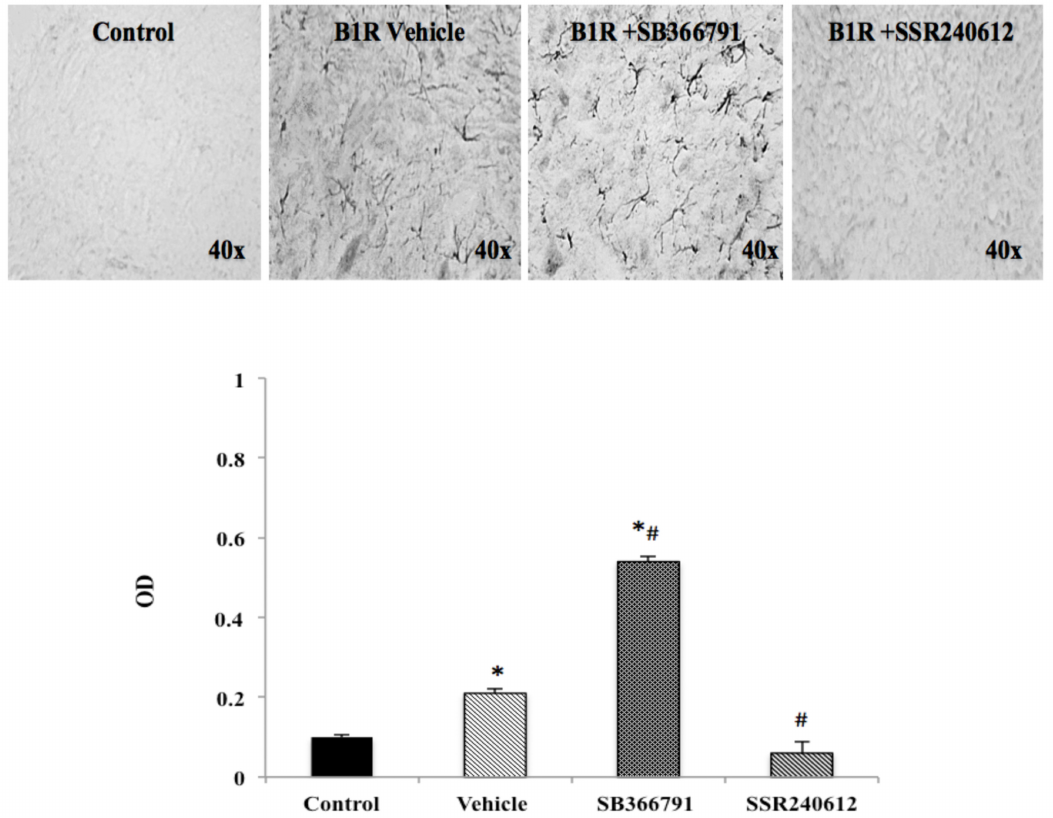
Figure 4. B1R protein expression in the ipsilateral dorsal horn of the spinal cord. Images represent digital microphotographs of B1R protein expression in the ipsilateral dorsal horn of partial sciatic nerve ligation (PSNL) rats revealed by color-based (DAB chromogen) immuno-enzymatic (biotin-streptavidin HRP) technique. Quantitative optical density values (on a scale of 1.0) are given for B1R in control, vehicle-treated, SB366791 and SSR240612-treated rats. Values are the mean ± SEM of 5 rats per group (each value is the mean of 5 sections per rat). Significance is indicated by * p < 0.05 vs. control and # p < 0.05 vs. vehicle-treated group, (F = 3.95, p < 0.0001). Magnification is 40 ×